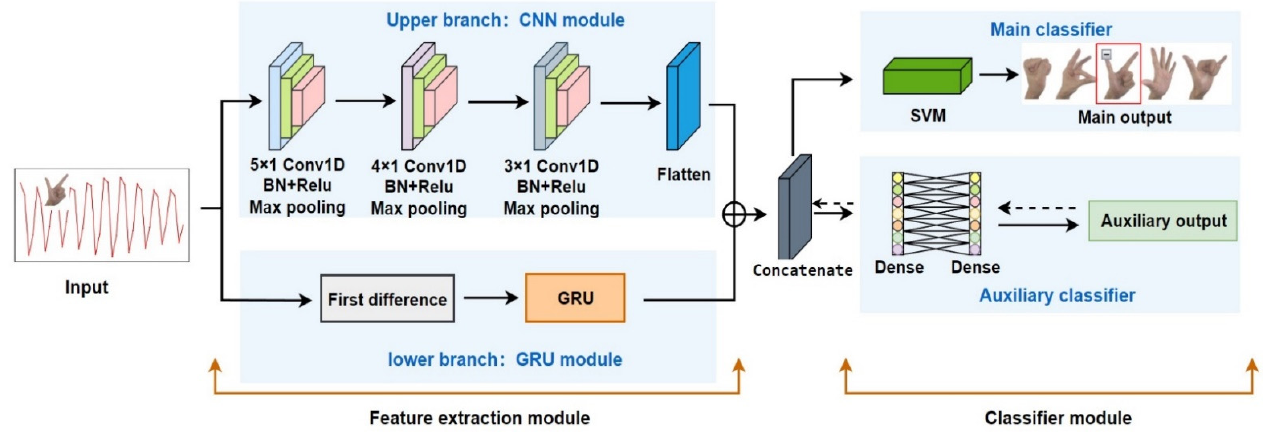
Figure 8. CG-SVM network structure.